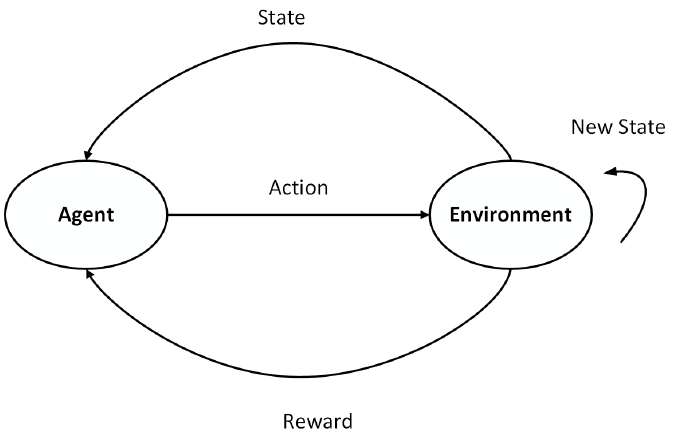
Figure 2. The schematic diagram of